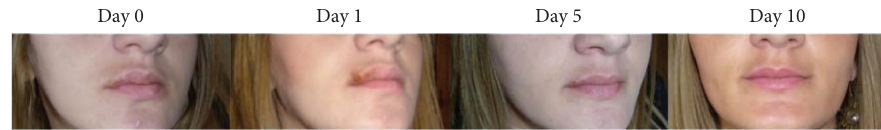
Figure 3: Visual chart for herpes labialis progression in a 27-year-old female infected with HSV-1.